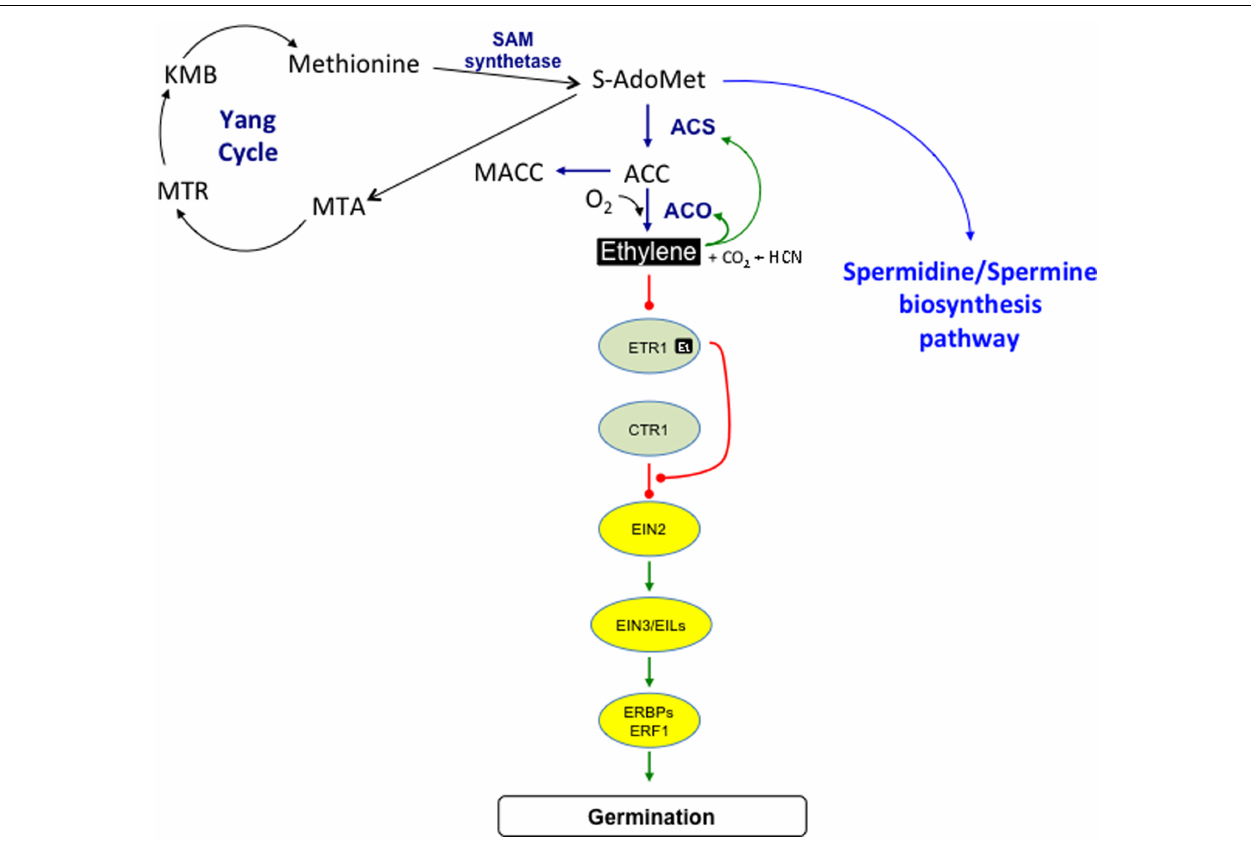
Ethylene can stimulate its own biosynthesis, by improving ACC synthesis catalyzed by ACS, and conversion to ethylene by ACO. Ethylene binds to receptors (among which ethylene receptor 1, ETR1) located in the endoplasmic reticulum, which leads to the deactivation of the receptors that become able to recruit CTR1 (constitutive triple response). Release of CTR1 inhibition allows EIN2 to act as a positive regulator of ethylene signaling pathway. EIN2 acts upstream of nuclear transcription factors, such as EIN3 (ethylene insensitive), EILs (EIN3-like), ERBPs (ethylene responsive element binding protein), and ERFs (ethylene response factor). −→ and — • arrows indicate positive and negative interactions between the different elements of the signaling cascade,